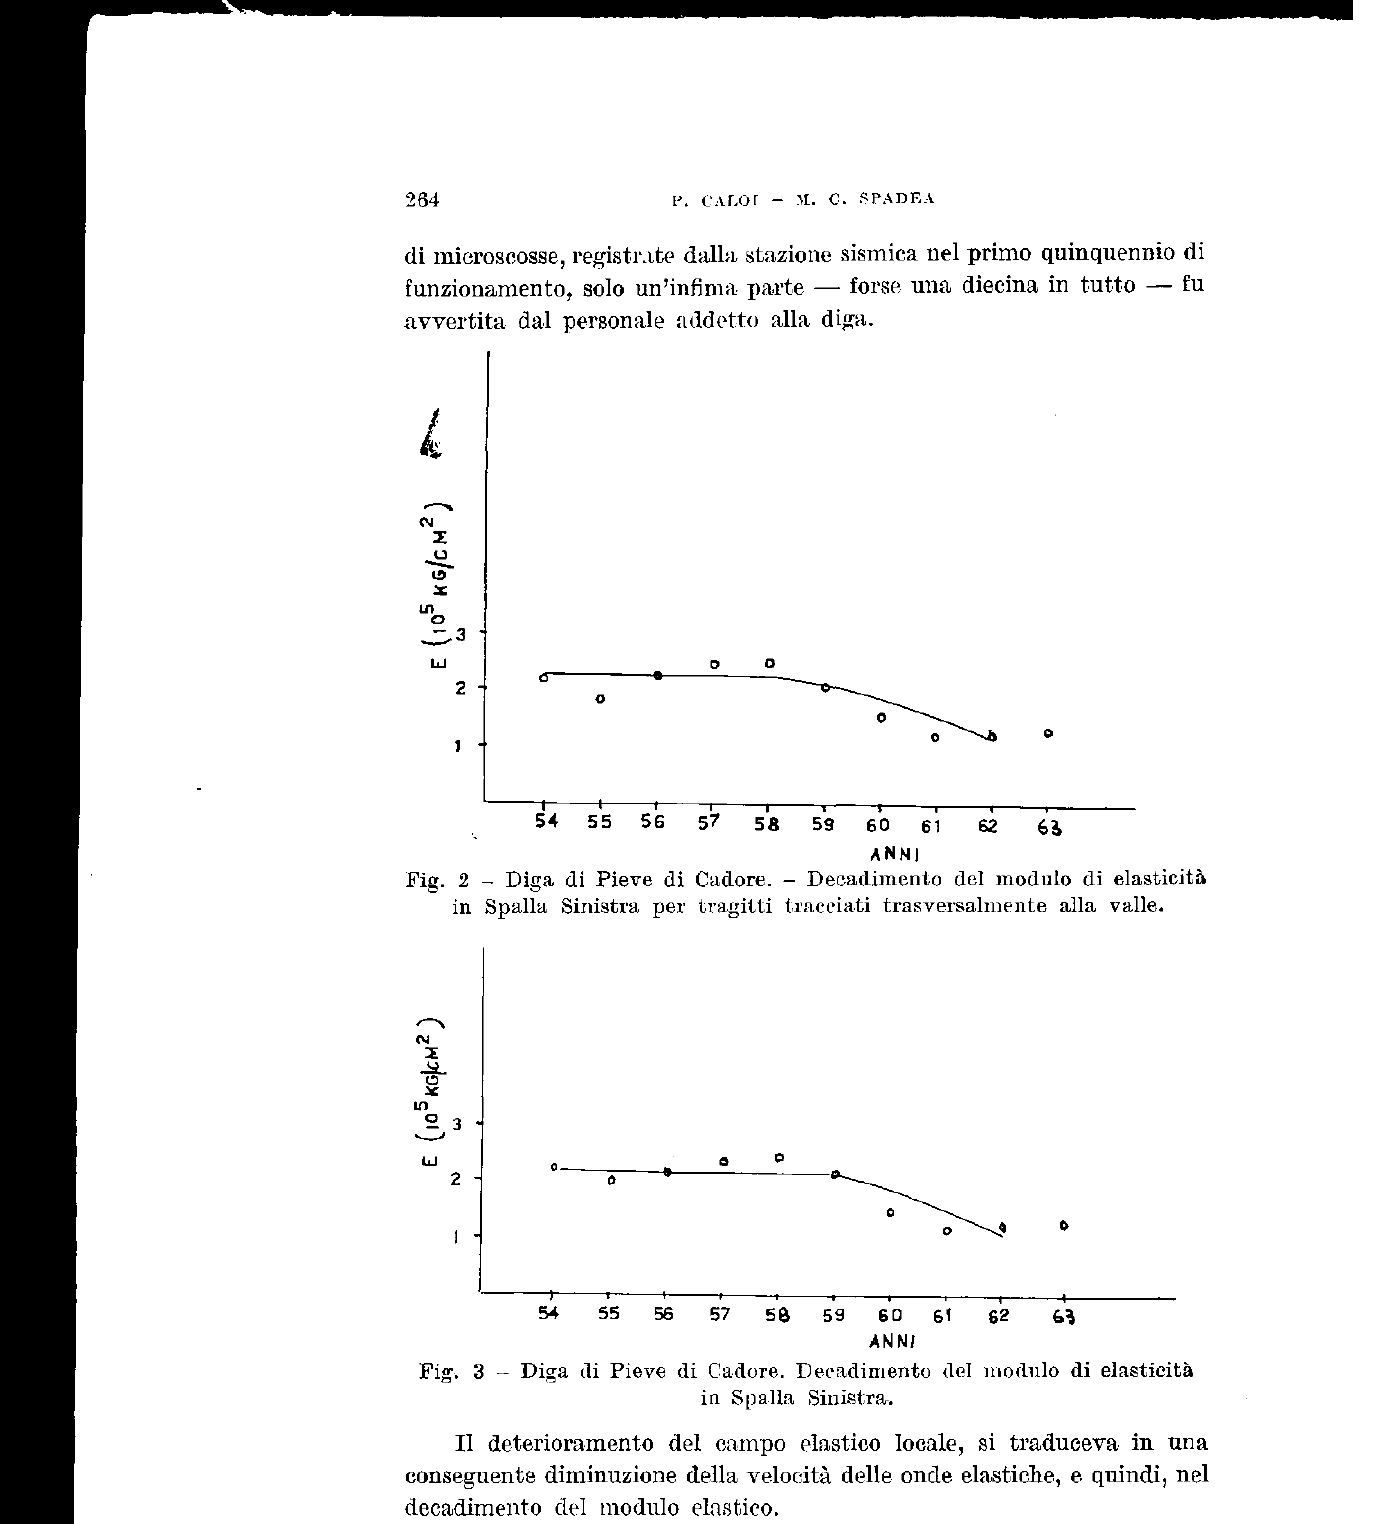
Fig-. 3 - Diga di Pieve di Cadore. Decadimento del modulo di elasticità in Spalla